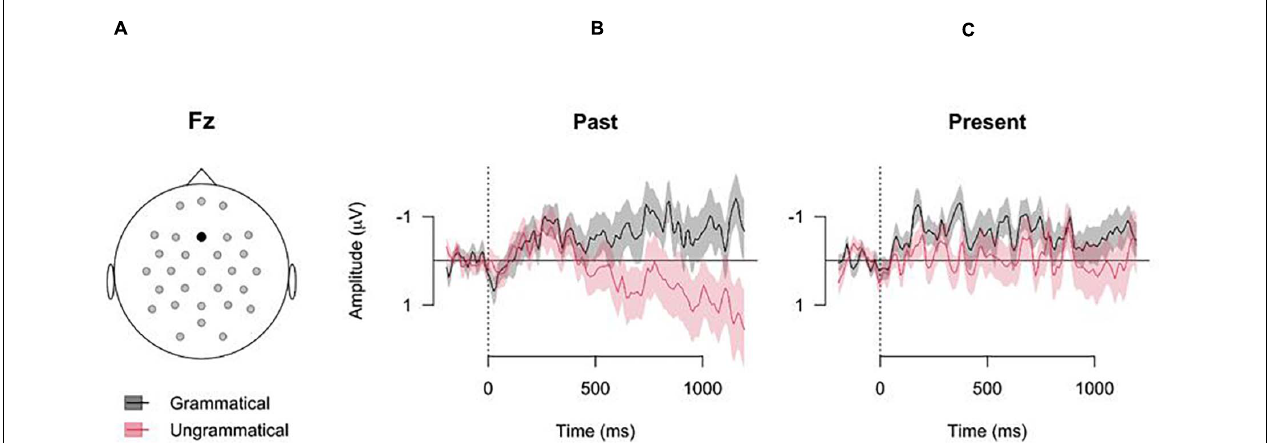
FIGURE 2 | Grand averages of electrode Fz (error bars: ± 1SE, based on participant means). The x -axes show the time (in ms) from verb onset, and the y -axes show the grand means of the recorded amplitudes (negative upward). (A) Electrode position. (B) Grand averages of the grammatical past tense sentences (black line) and the ungrammatical past tense sentences (red line). (C) Grand averages of the grammatical present tense sentences (black line) and the ungrammatical present tense sentences (red line).